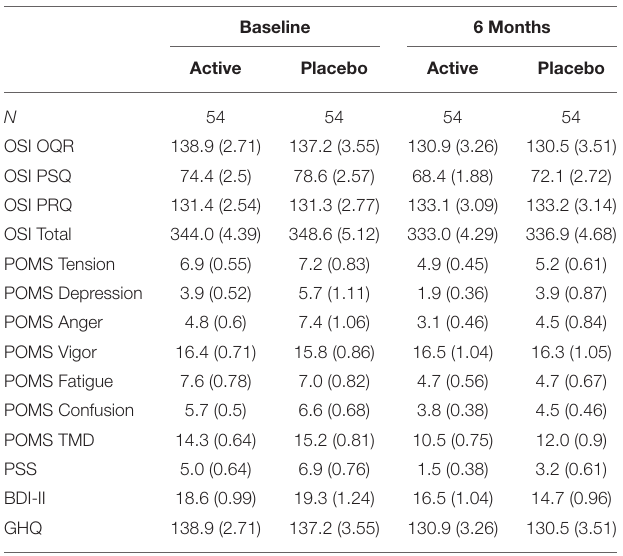
TABLE 1 | Means and standard error for psychometric indices between groups for the total sample at baseline and following 6-month supplementation of the high-B-vitamin multivitamin.